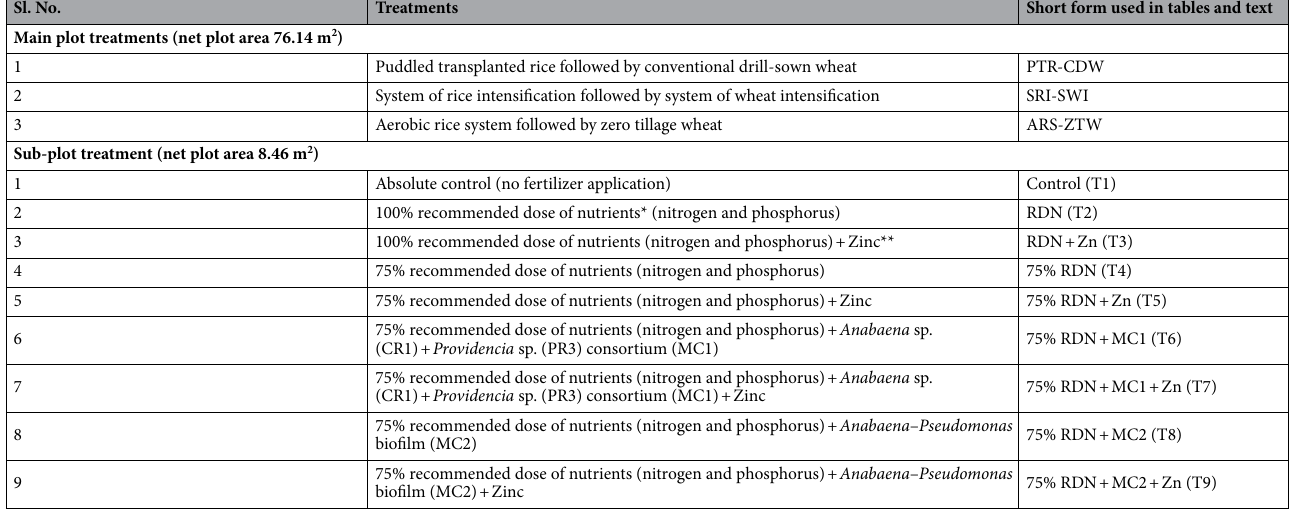
Table 14. Treatment details applied in rice–wheat cropping system and respective abbreviations used throughout the text. 100% recommended dose of nutrients*: 120 kg nitrogen ha –1 and 25.8 kg